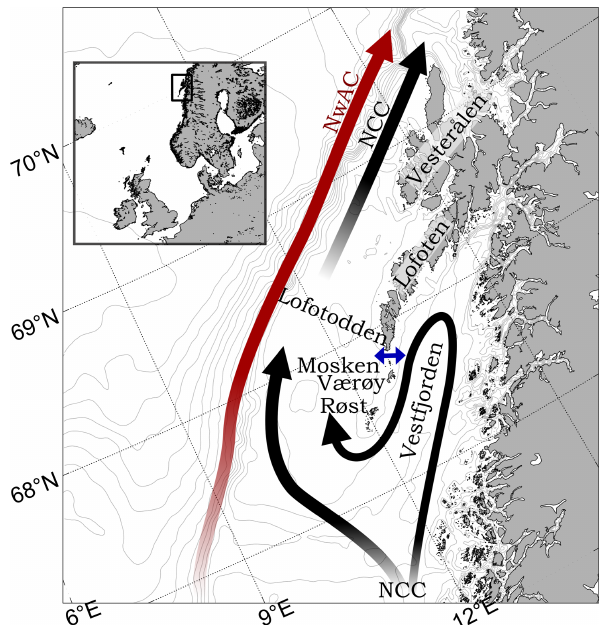
Figure 1. The general ocean surface circulation in the Lofoten– Vesterålen region. Black arrows show the Norwegian Coastal Cur- rent (NCC) and the red arrow shows the Norwegian Atlantic Cur- rent (NwAC). The blue two-headed arrow shows the location of Moskstraumen, situated between Lofotodden to the north and the small island of Mosken to the